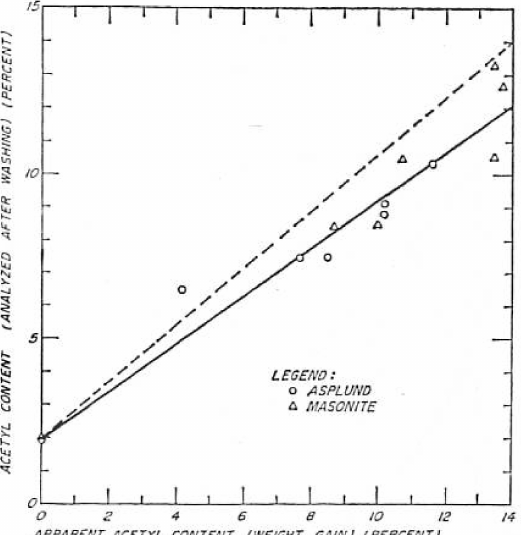
Figure 14. Relationship between analyzed acetyl content and dry weight gain due to acetylation of Asplund and Masonite hardboards [17].